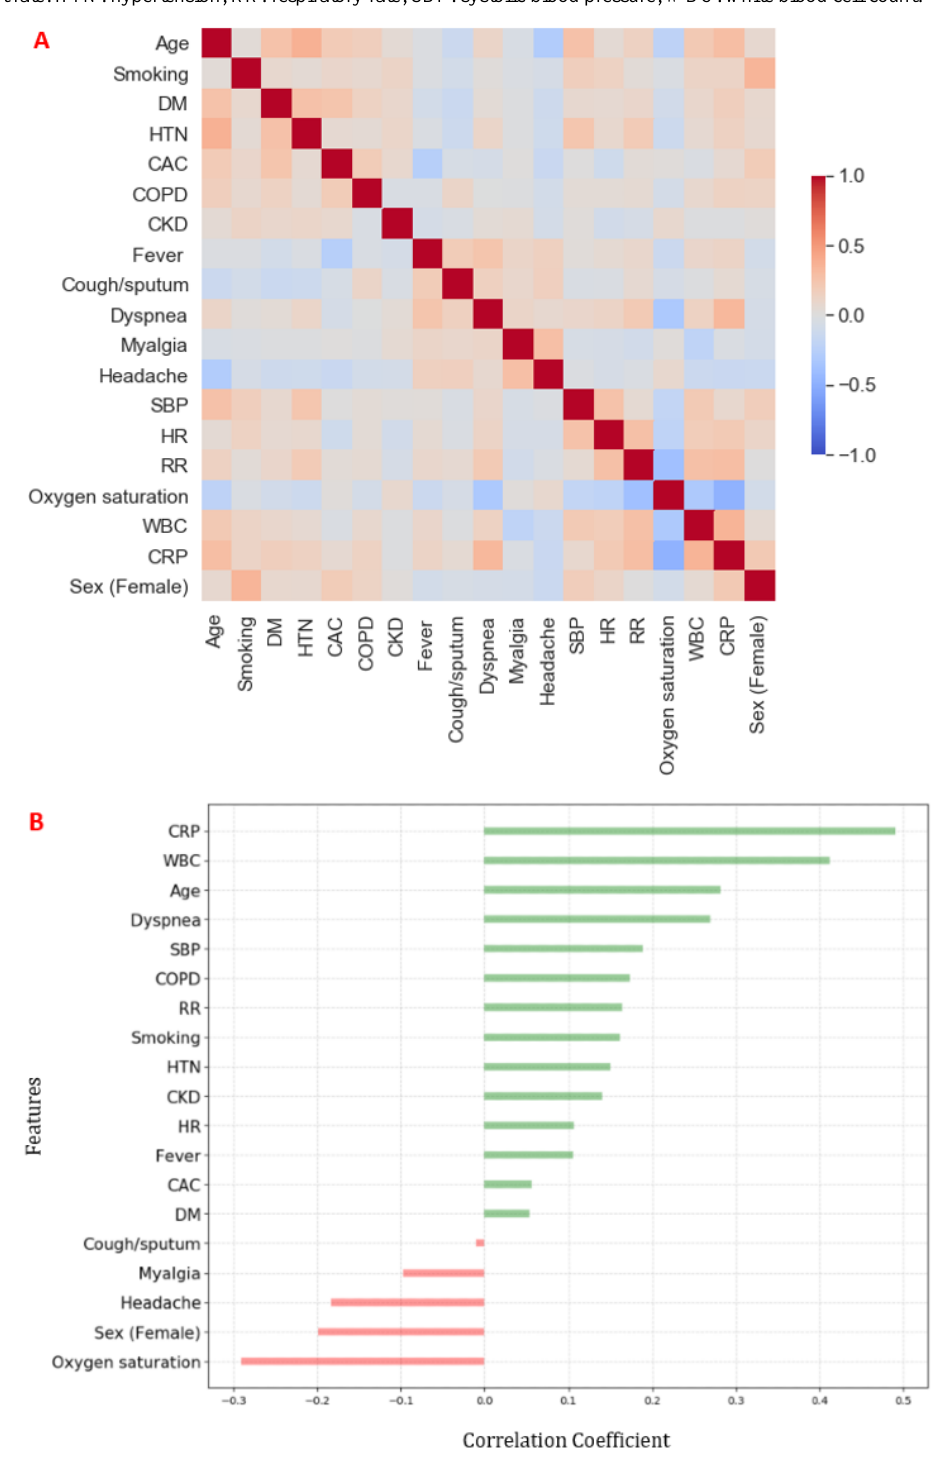
Figure 3. A. Correlation heatmap of clinical features with the endpoint (event vs event-free). B. Diverging bars of important features with endpoint. CAC: coronary artery calcification; CKD: chronic kidney disease; COPD: chronic obstructive pulmonary disease; CRP: C-reactive protein; DM: diabetes mellitus; HR: heart rate: HTN: hypertension; RR: respiratory rate; SBP: systolic blood pressure; WBC: white blood cell count.